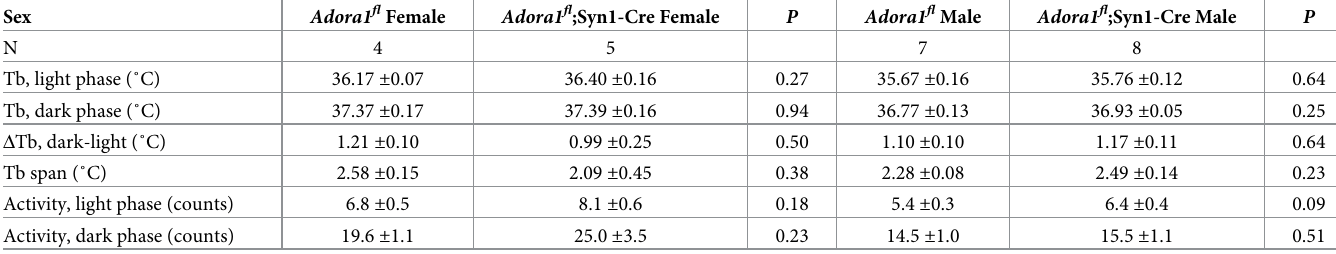
Data collected from 5-month old mice over a continuous 96-hour interval. Tb span is the 95 th minus the 5 th percentiles. Data are mean ± SEM. P values are from unpaired t-tests comparing genotype within sex.